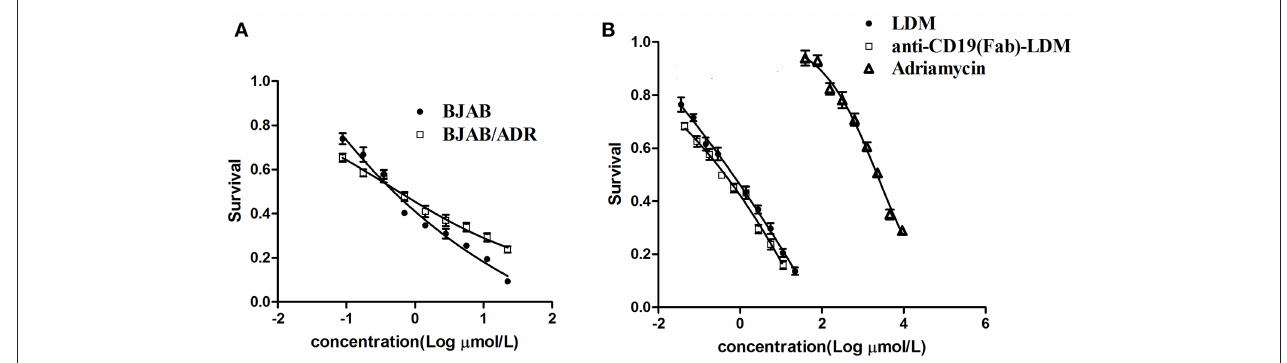
FIGURE 5 | Antitumor activity of anti-CD19(Fab)-LDM on ADR resistant cells. Antitumor activity of anti-CD19(Fab)-LDM on BJAB and BJAB/ADR cells assessed by MTT assay. (A) The anti-CD19(Fab)-LDM has a similar cytotoxic effect on resistant cells and their corresponding parental cells. (B) The anti-CD19(Fab)-LDM had a